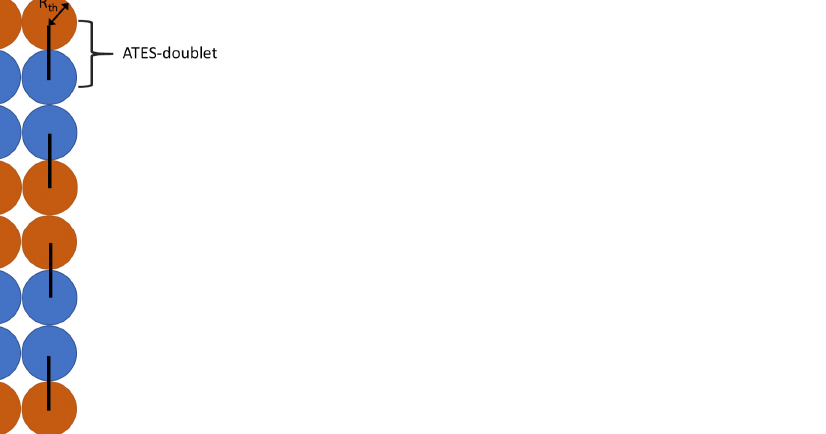
Figure A1. Thermally-active aquifer areas according to square packing of circles with identical radii.